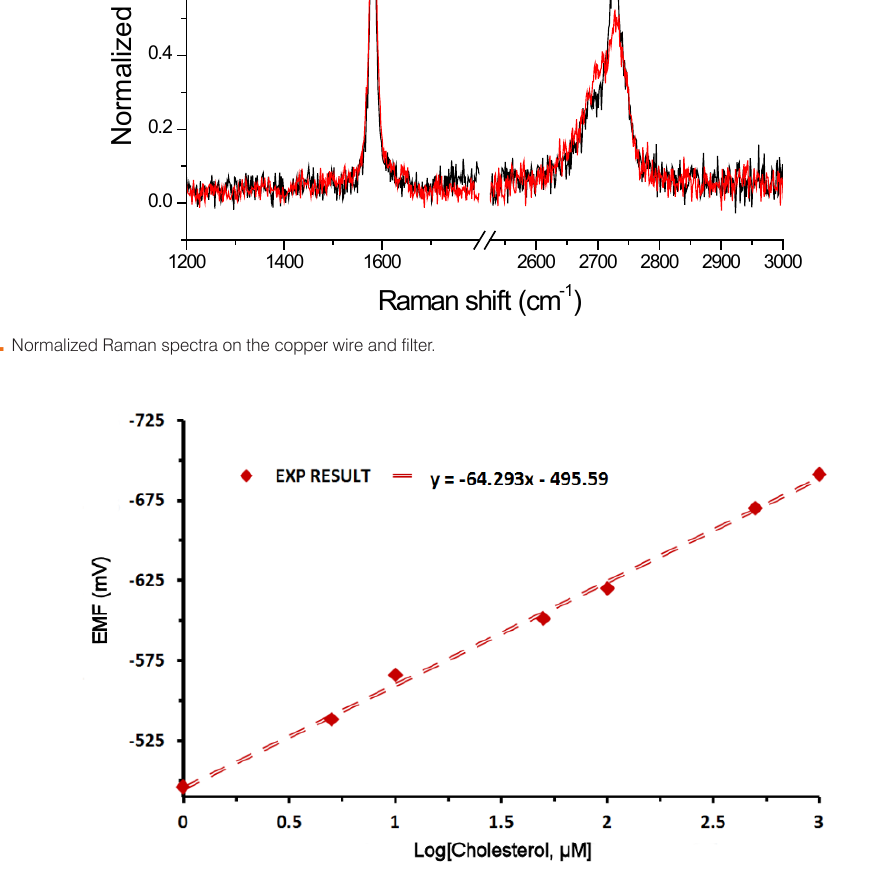
Figure 5. Calibration curve of the cholesterol